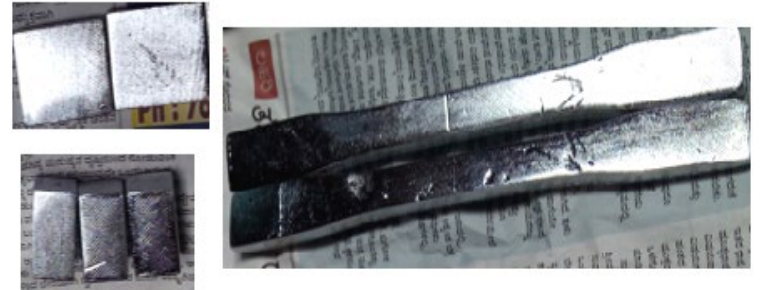
Figure 5. Electroless nickel-plated PETG+MWCNT specimens.